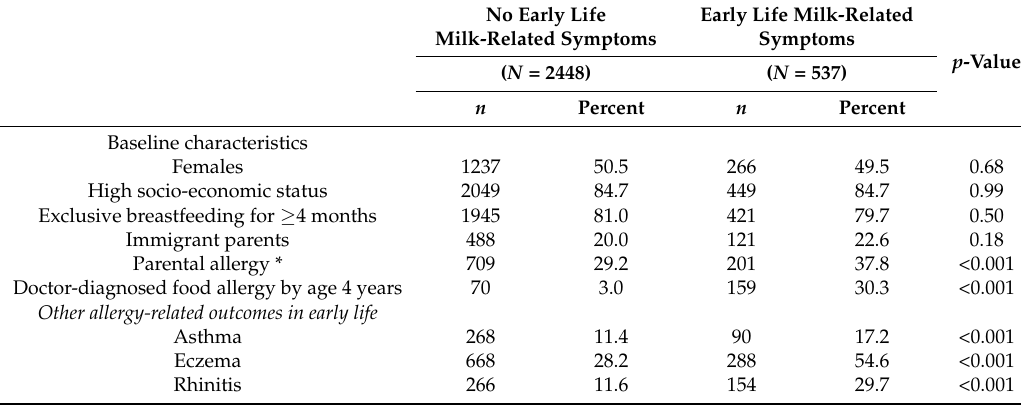
Table 2. Distribution of baseline characteristics in relation to symptoms of early life (to age four years) milk reported symptoms ( N =